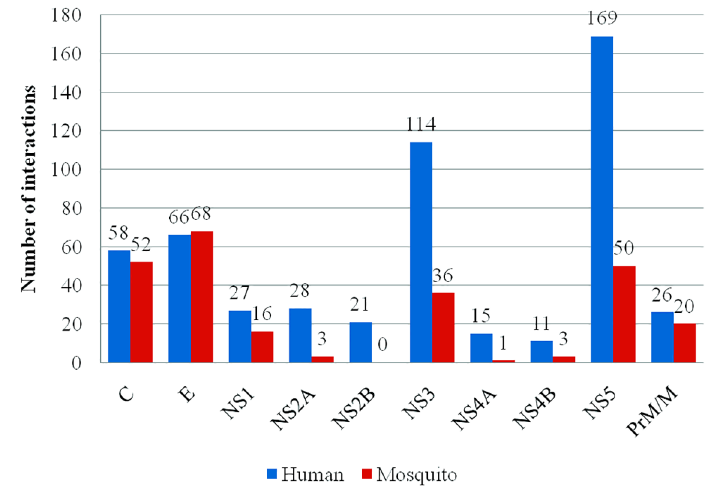
Fig 4. Dengue virus proteins’ frequency of interaction with human proteins and mosquito proteins. The dengueprotein NS5 interacts with maximum number of humanproteins (169), and dengueprotein E interacts with maximum number of